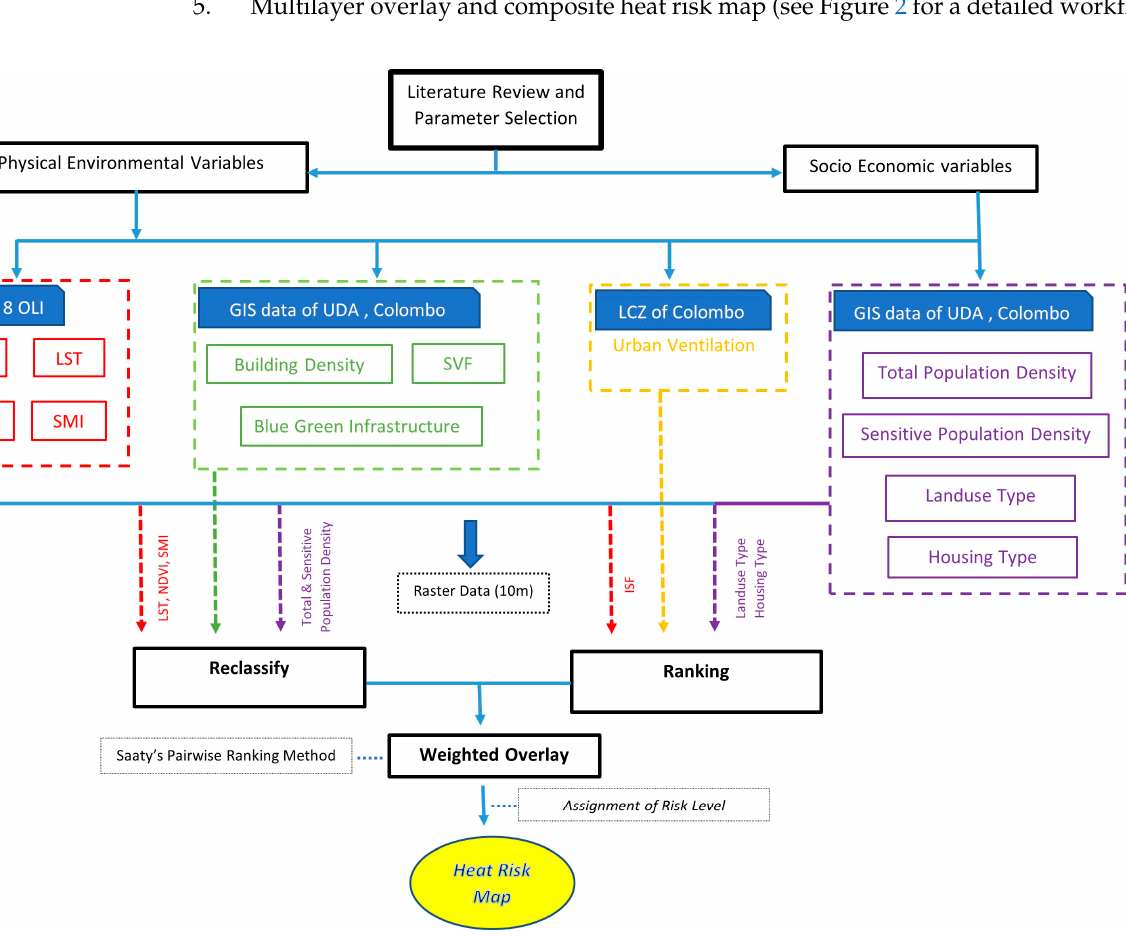
Figure 2. Heat risk mapping workflow.